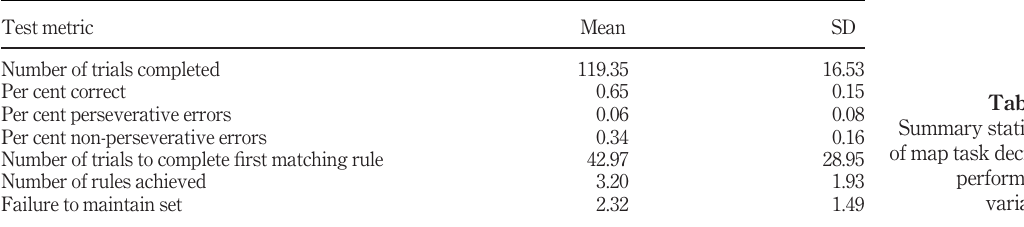
Table I. Summary